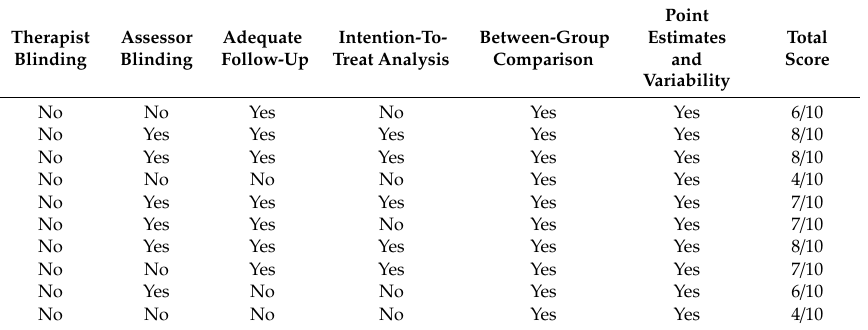
Table 3. Quality of the studies included in the meta-analysis (Physiotherapy Evidence Database, PEDro